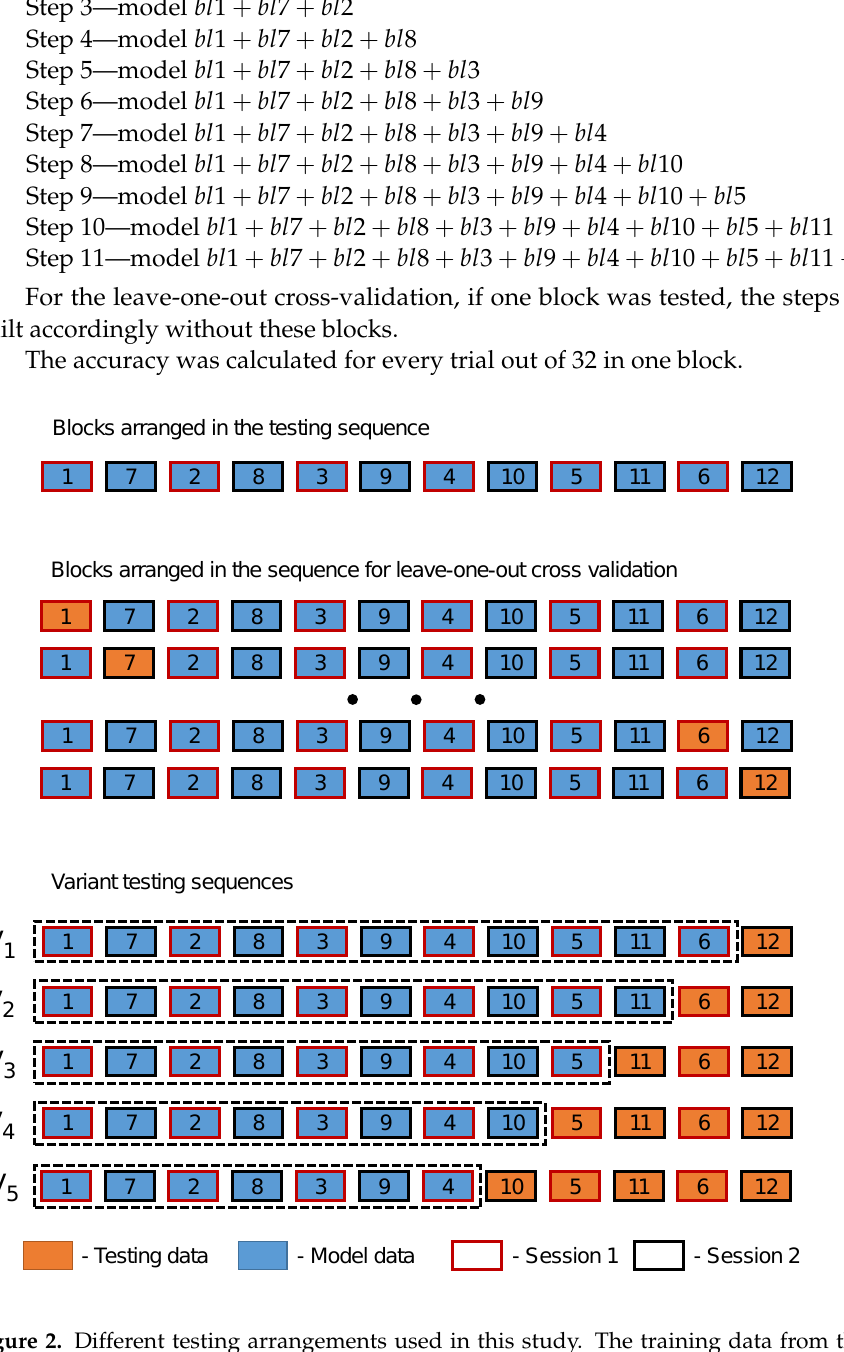
Figure 2. Different testing arrangements used in this study. The training data from the original experiment [15] were divided into 12 blocks and rearranged into a testing sequence, which was divided into model building and testing